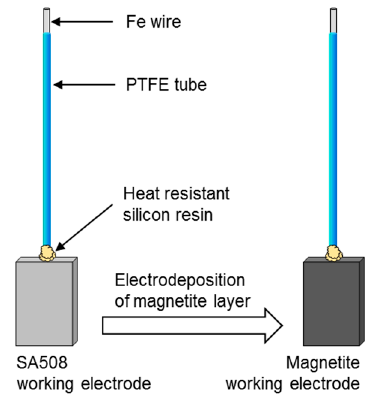
Figure 1. Schematic of a magnetite working electrode prepared using the electrodeposition method.